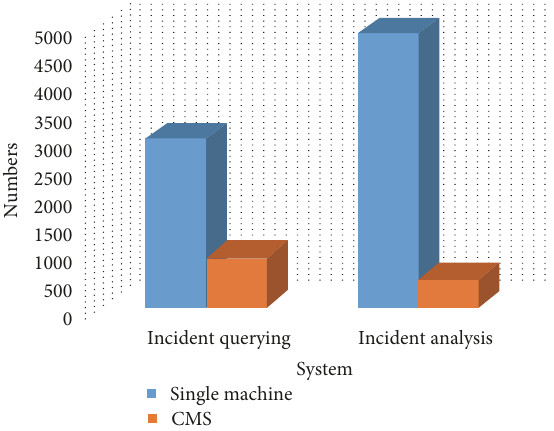
Figure 6: The comparison of the time cost on different